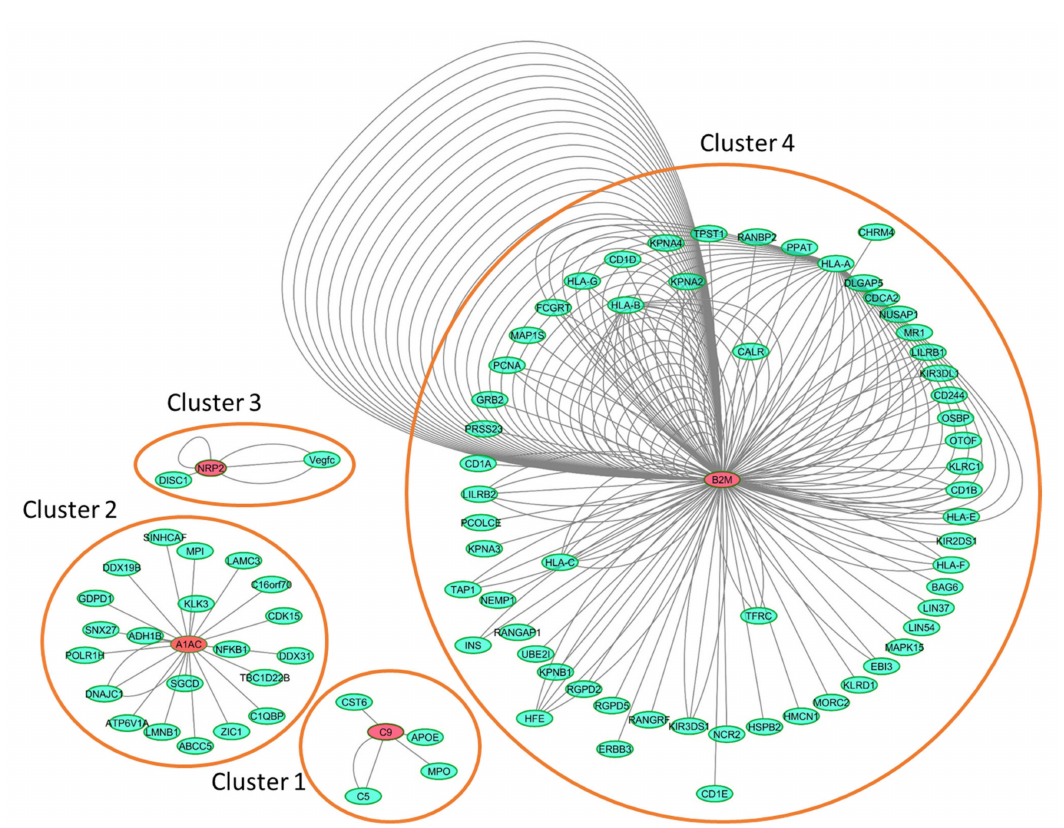
Figure 5. Human IntAct network generated with the four identified biomarkers and their interactors. Details on the network components are reported in Table